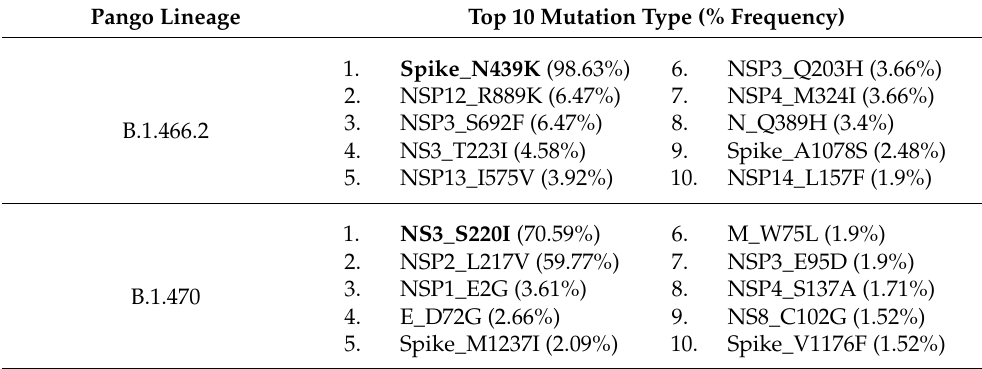
Table 4. Unique mutations found in two of the Indonesian variants.